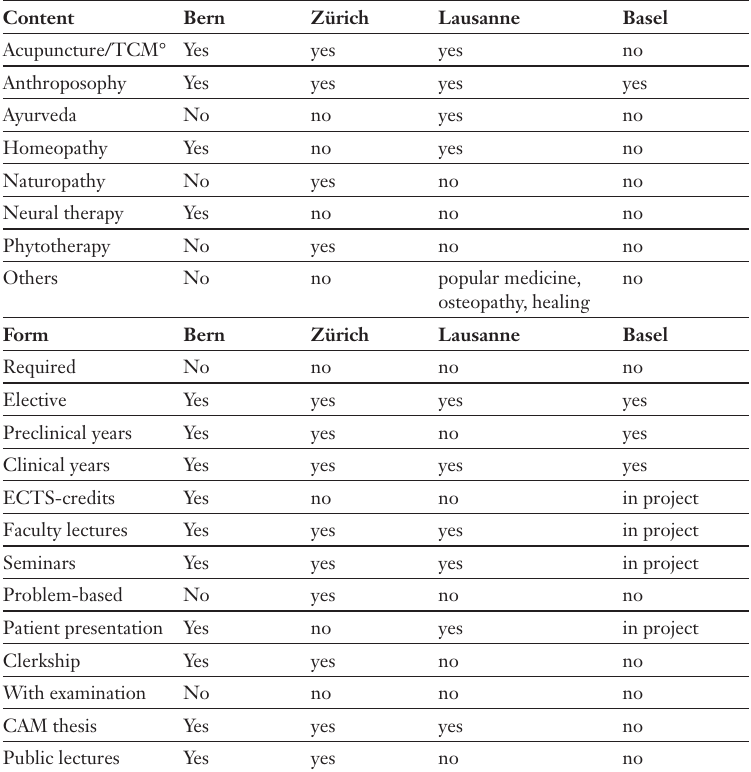
Content and form of CAM education at Swiss Medical Schools*.